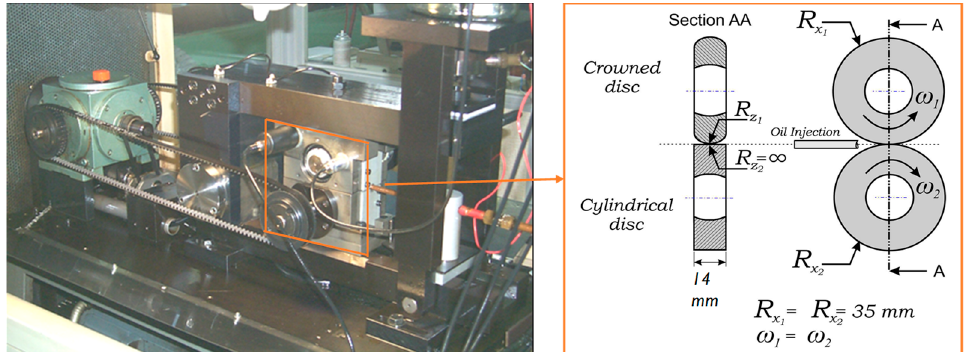
Figure 4. Twin-disc test machine and schematic representation of the geometry of ring specimens.